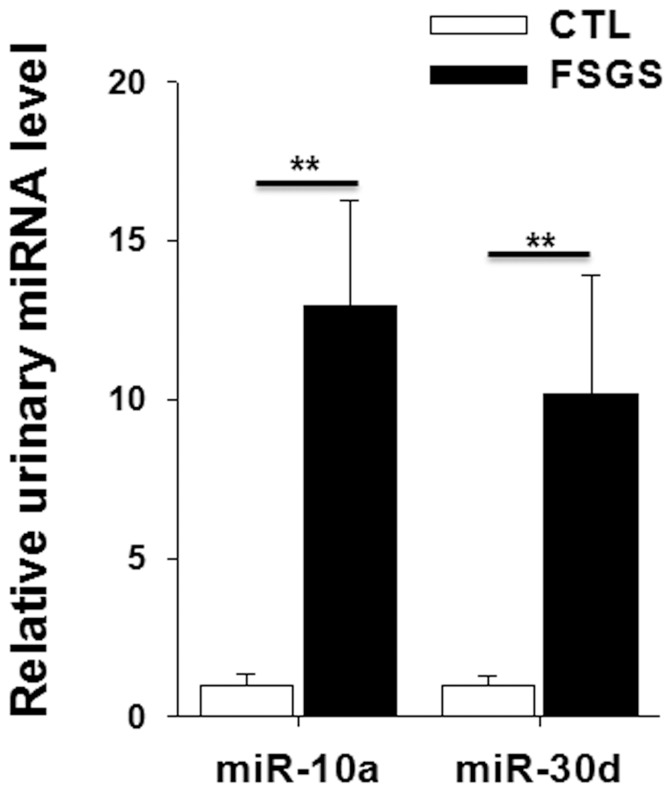
Alteration of the urinary miR-10a and miR-30d levels in FSGS patients.Urine samples were collected from 16 healthy donors and 16 FSGS patients. Note that, compared with healthy donors, FSGS patients had strikingly elevated levels of urinary miR-10a and miR-30d. **, p<0.01.